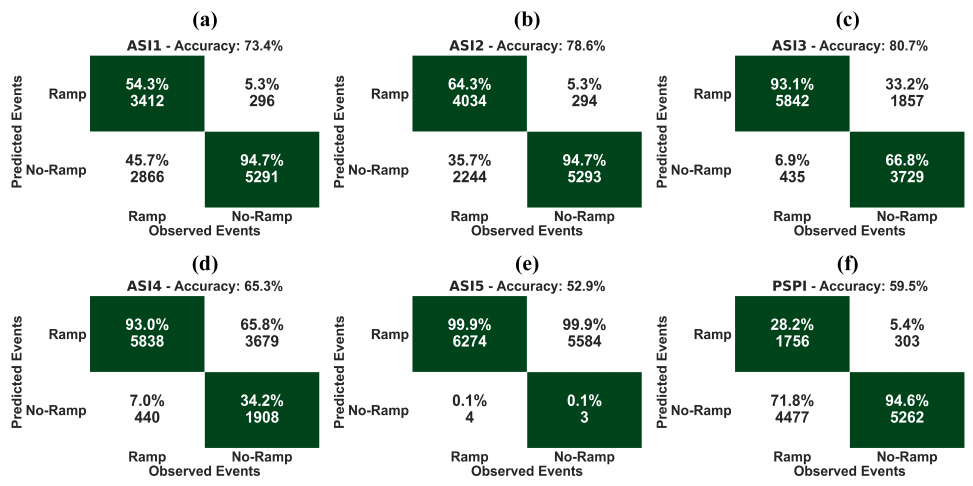
Figure 6. Confusion matrix including all possible cases of Table 2 for ( a ) ASI1, ( b ) ASI2, ( c ) ASI3, ( d ) ASI4, ( e ) ASI5 and ( f ) PSPI. The percentages of each quadrant are calculated based on the true measured cases (either for ramp or no-ramp events) and refer to the ramp event detection within the 20 min window analysis (see Section